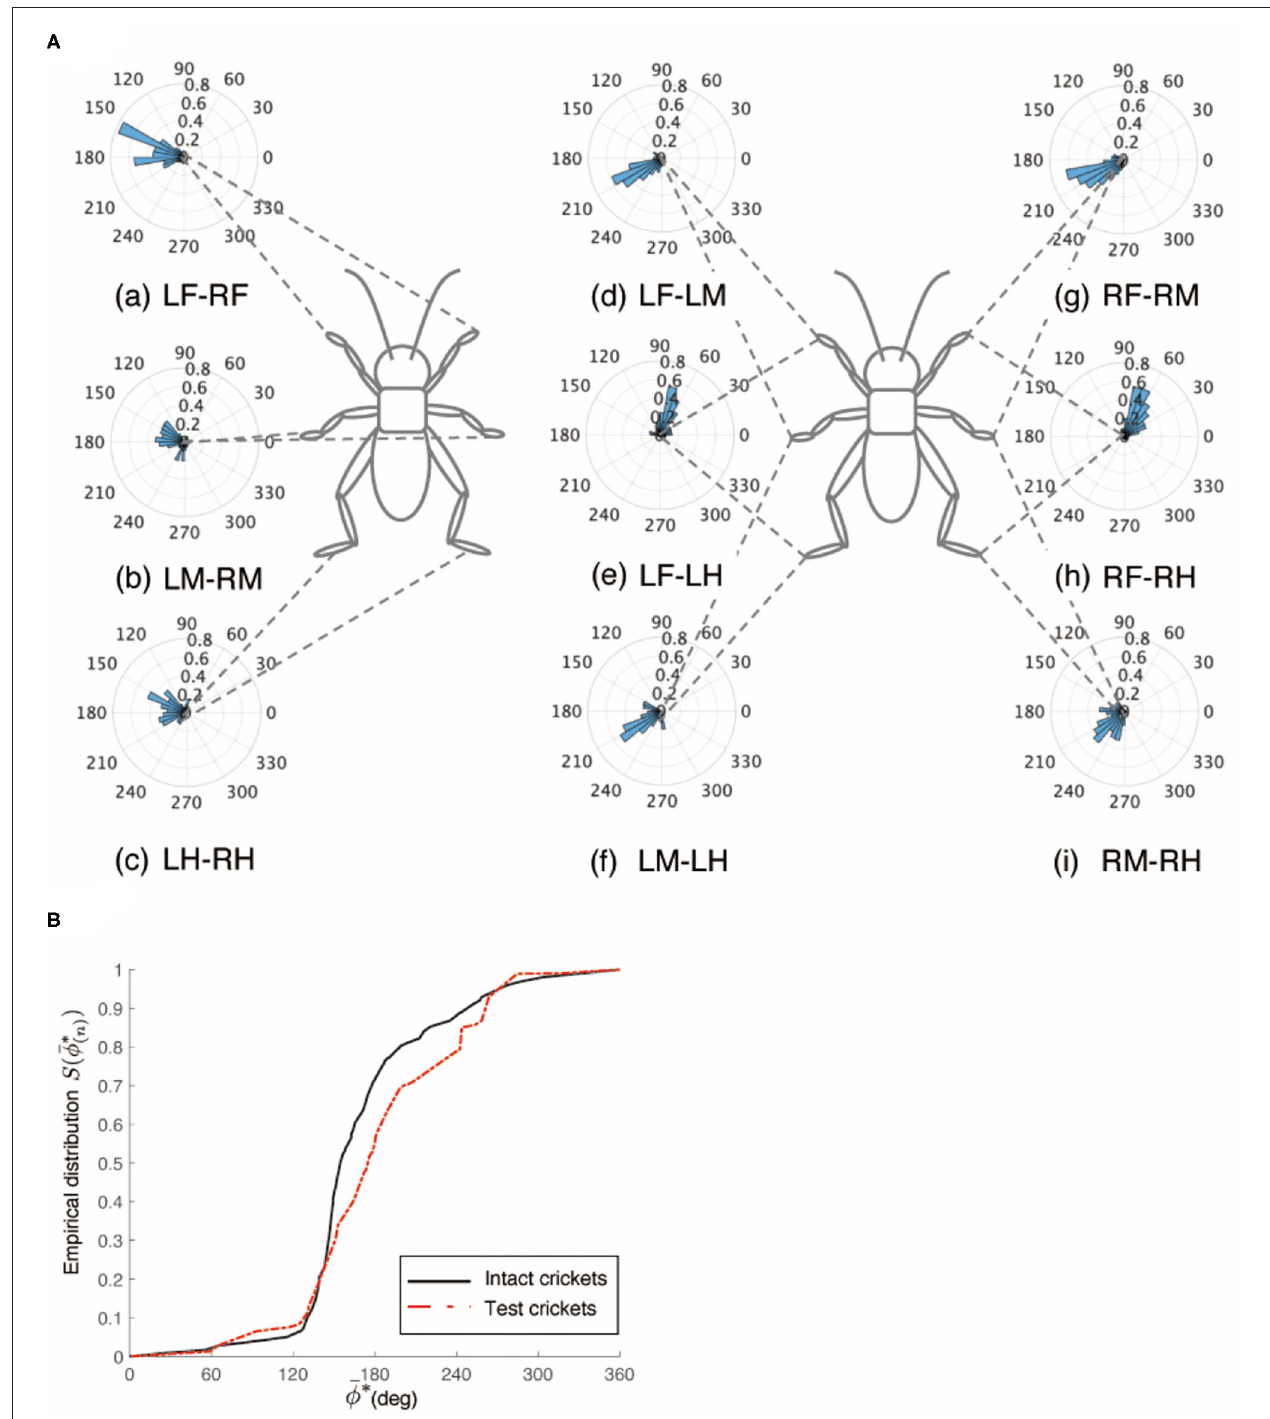
FIGURE 9 | Walking gait patterns of crickets in which left side of nerve connectives between metathoracic ganglion and abdominal ganglia was cut. (A) Polar histograms indicate phase differences between two legs in test crickets ( N = 5). The polar histograms demonstrate that the test crickets exhibited a tripod gait pattern on the floating ball of the treadmill. (a–i) Phase differences between pairs of legs. (B) Comparison of the empirical distribution function of phase differences between left and right legs Φ LM − RM . The black line indicates the empirical distribution function of the intact crickets and the red line indicates that of the crickets in which the left side of the nerve connectives between the metathoracic ganglion and abdominal ganglia was cut. LF, left foreleg; RF, right foreleg; LM, left midleg; RM, right midleg; LH, left hind leg; RH, right hind leg.